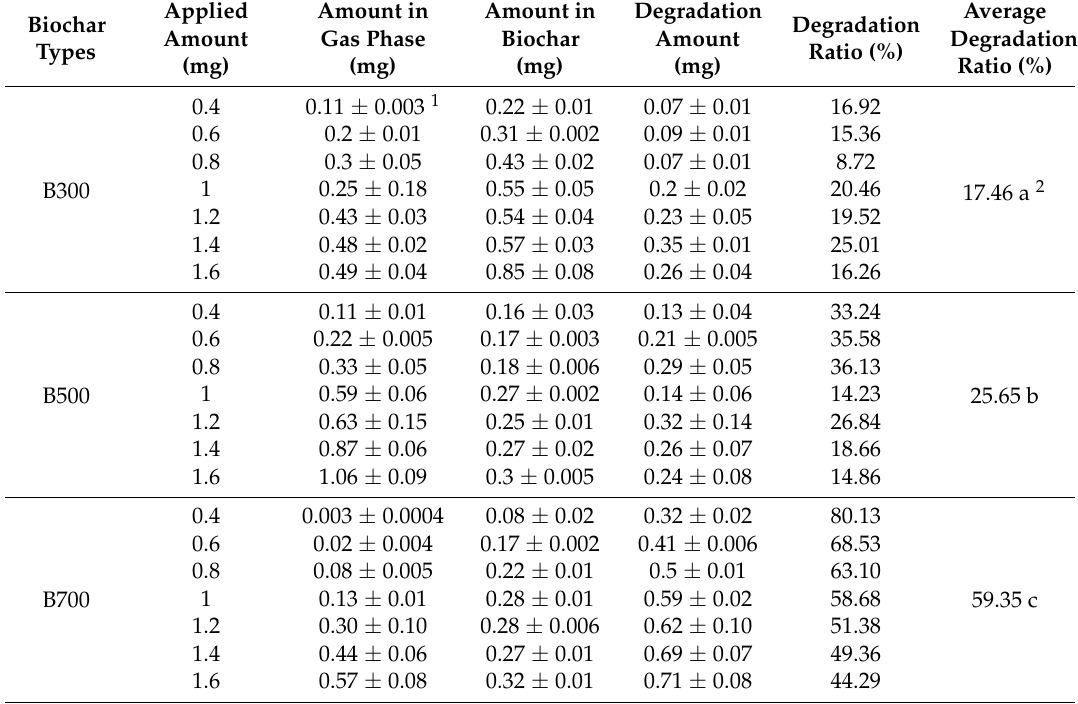
Table 4. The fate of CP after application to the biochars.